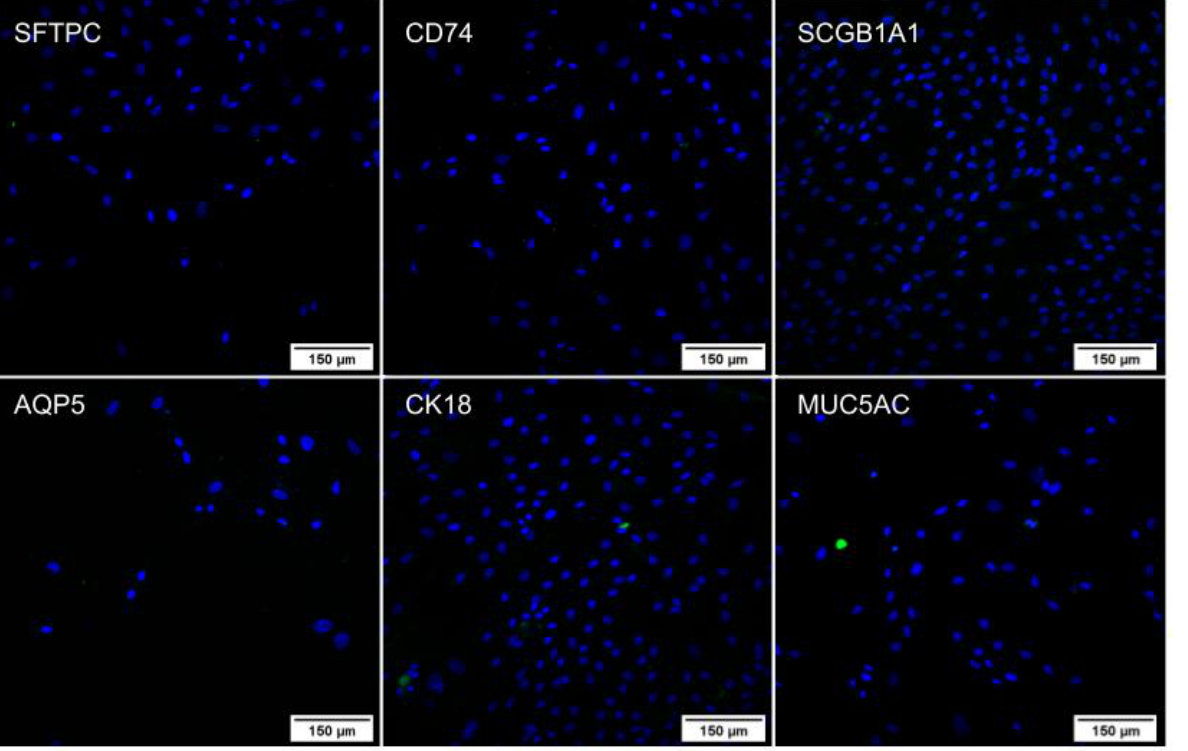
Figure 5. Immunocytochemistry of undifferentiated WJ-MSC (sample C6) with DAPI marking the nuclei in blue and FITC marking the specific proteins in green. Images obtained using a high- throughput microscope In Cell Analyzer 2000 (GE Healthcare ® , Chicago, IL, USA).